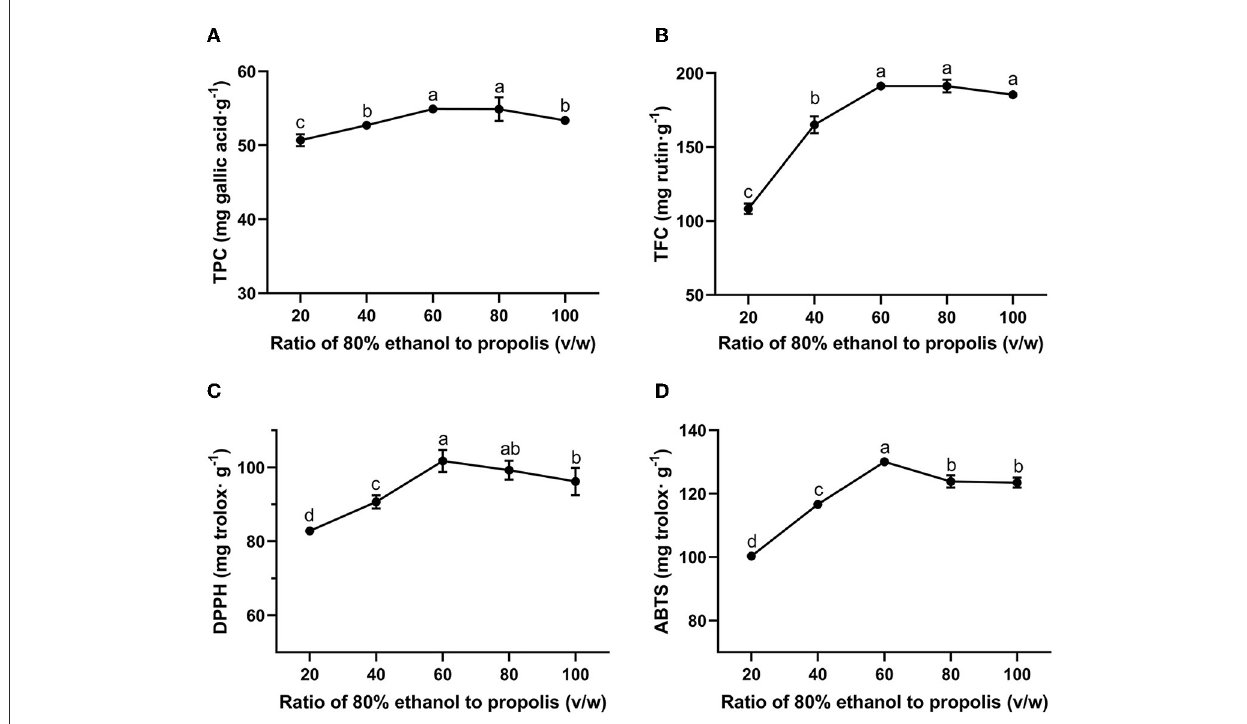
FIGURE1 Effect of liquid-to-solid ratio on TPC (A) , TFC (B) of propolis extracts and their antioxidant activities meassured by DPPH (C) and ABTS (D) assays. Different superscripts indicate significant differences as estimated by Duncan’s multiple range test ( P < 0.05).